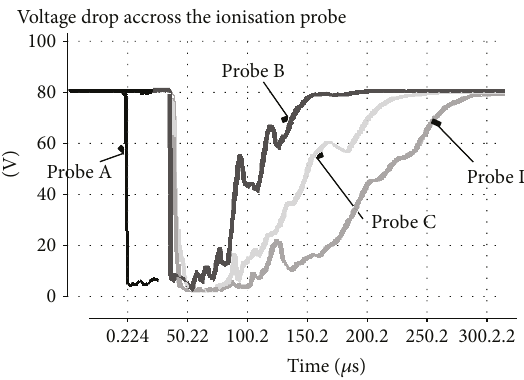
Figure 11: Records from four ionisation probes, one of them (probe A) was wrongly adjusted in this particular test (later, of course, its conical body was rotated to get the desirable full synchronisation).